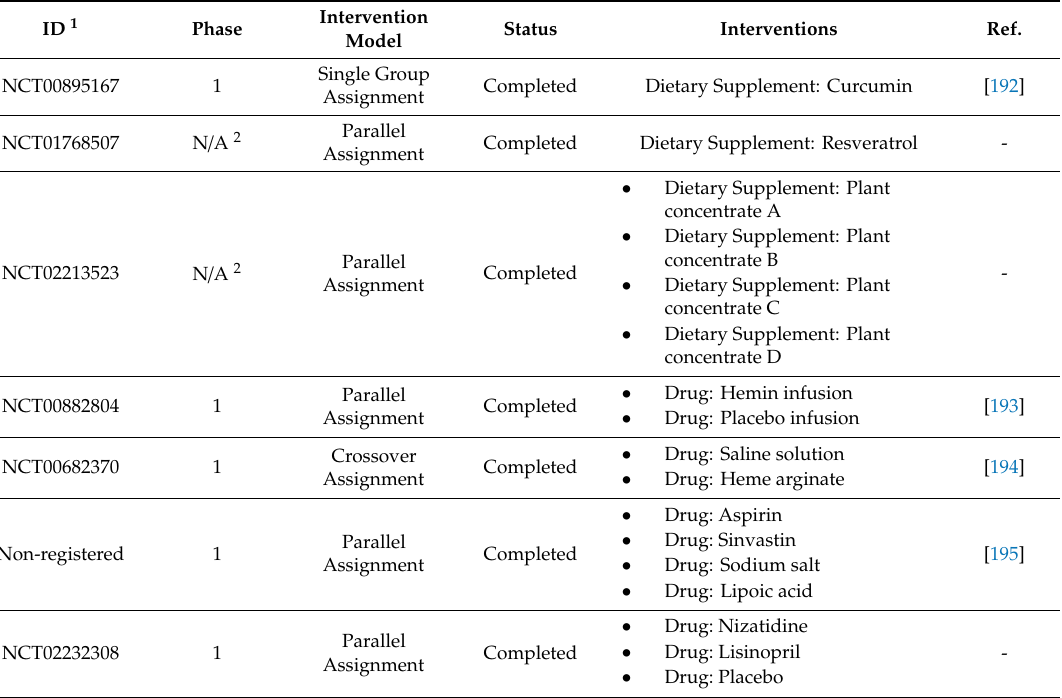
Table 1. Clinical trials carried out in healthy